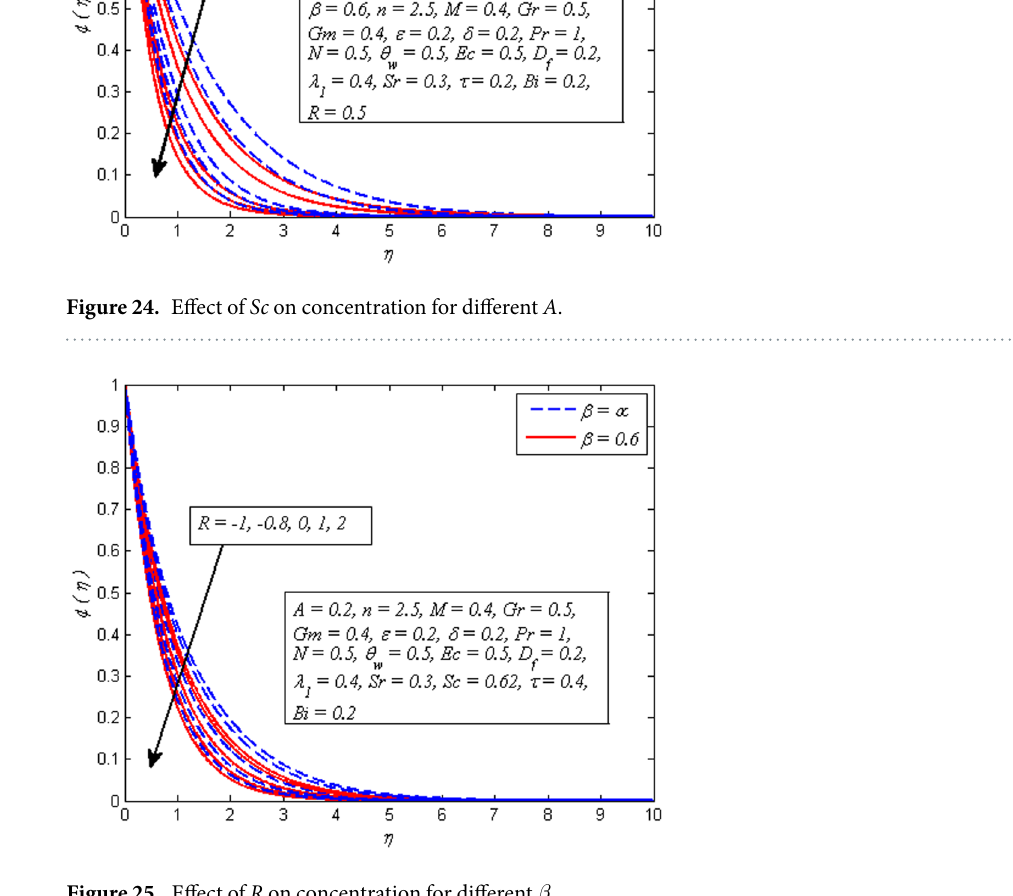
Figure 25. Effect of R on concentration for different β .